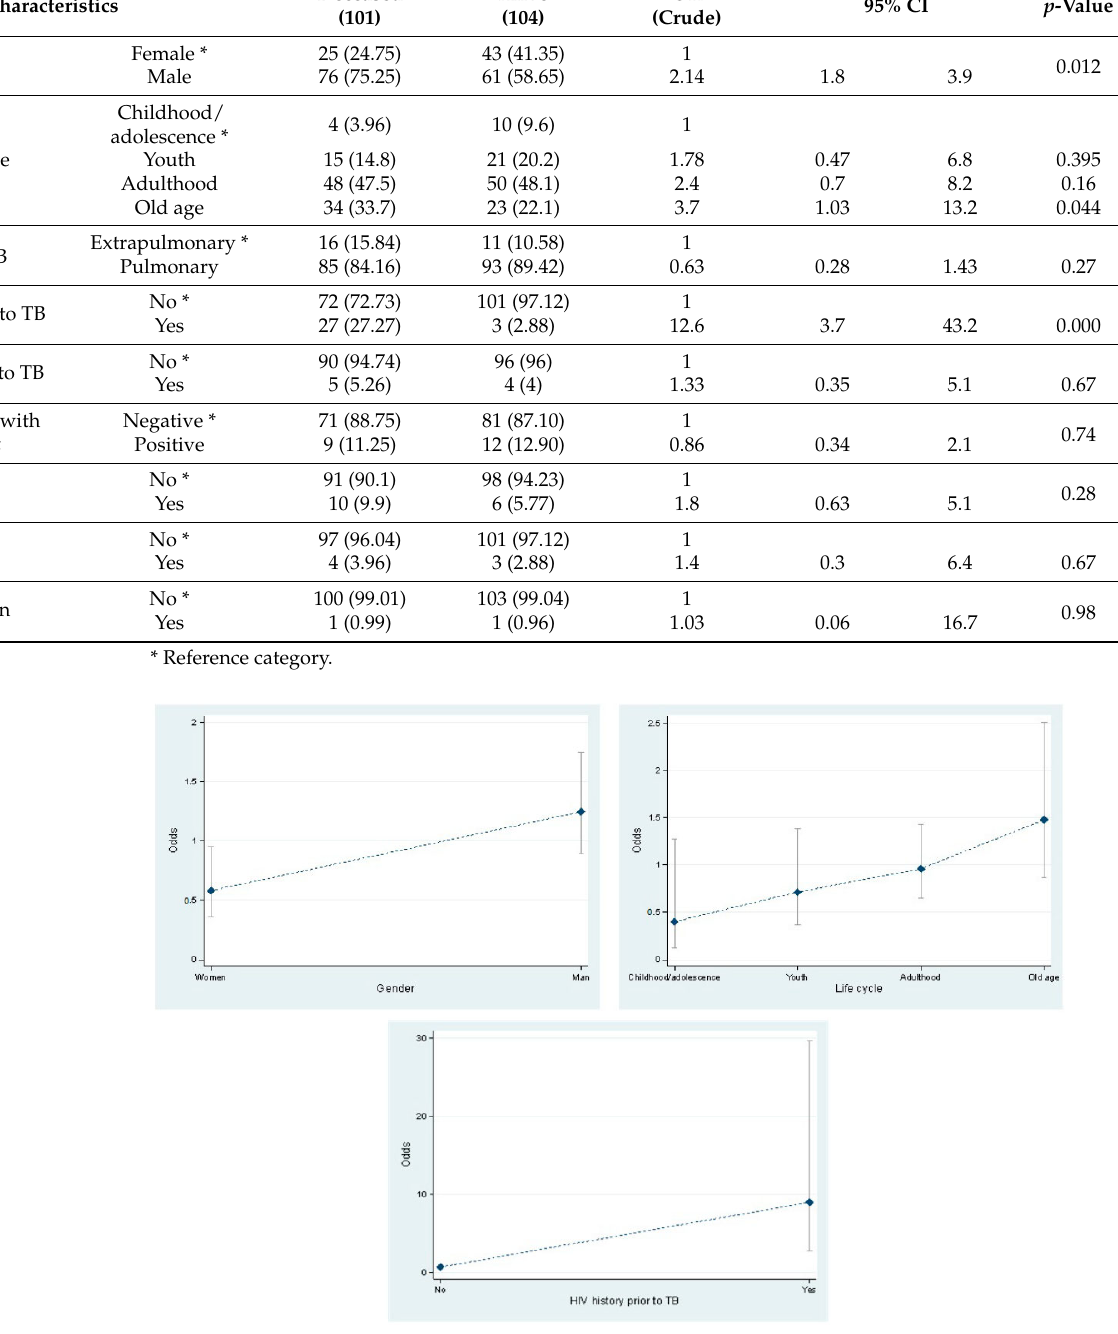
Figure 3. Association between gender, life cycle stage, HIV history, and TB mortality. The indigenous population with a history of HIV prior to TB had 12.6 times the chance of dying from TB compared to those who did not have a previous history of HIV ( p = 0.00). Likewise, those who tested positive for HIV had 20 times the chance of dying from TB compared to those who tested negative for HIV ( p = 0.000).